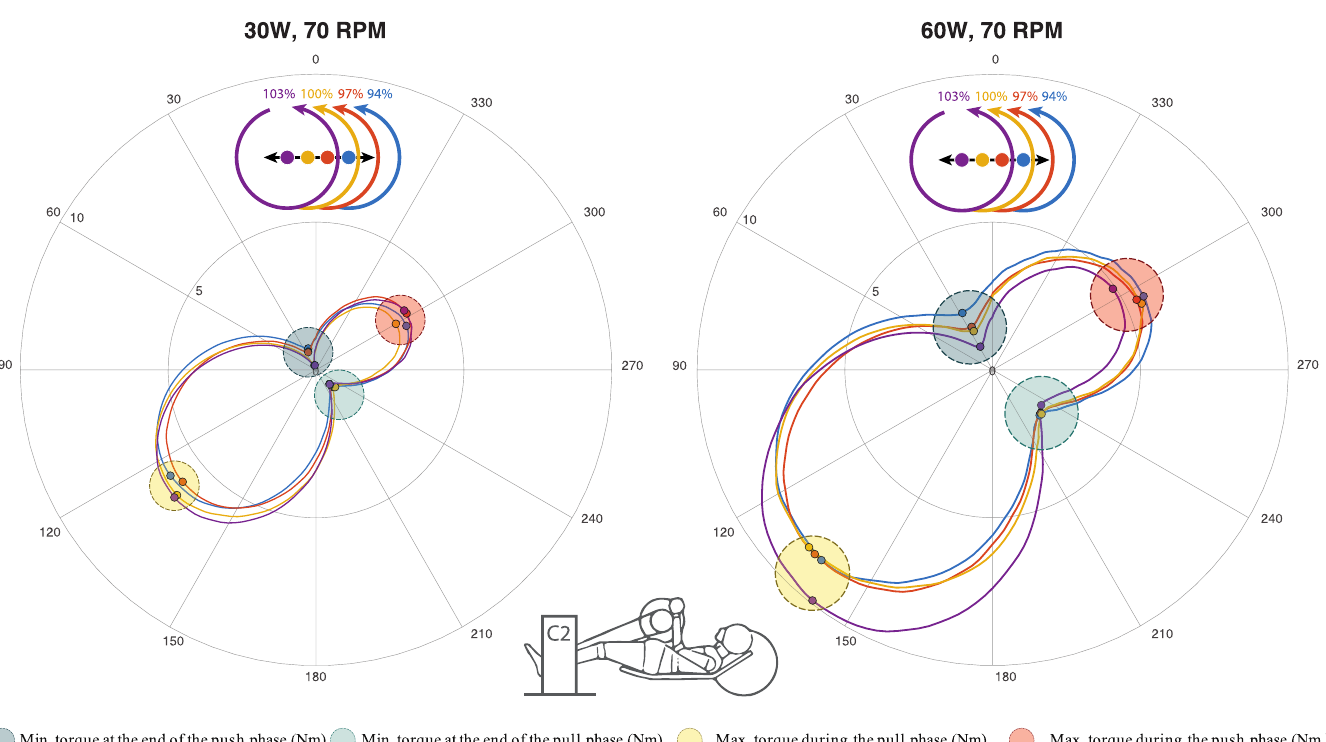
Fig 3. Torque profiles per crank fore-aft position, averaged over all full cycles over the last minute and all participants in the 30W (left) and 60W (right) conditions. C2 stands for Cyclus2 (Handcycle ergometer). Contrasts revealed that the minimal torque at the end of the push phase decreased, the maximal torque in the pull phase increased and the percentage of work done in pull phase increased when the crank-fore-aft position increased.